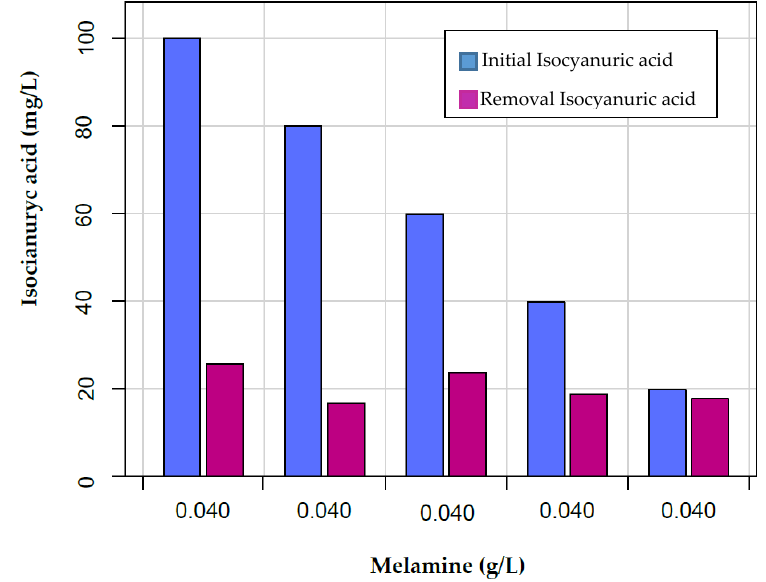
Figure 7. Variation of isocyanuric acid removed in the filtered water versus the addition of 0.04 g/L of melamine.